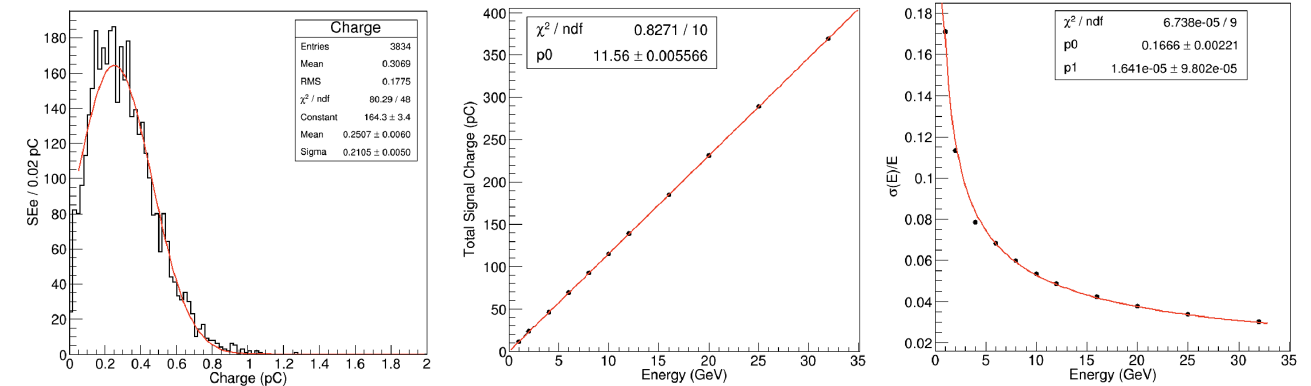
Figure 5. The simulated charge spectrum of a single layer ( left ), the MC predictions of the response linearity ( center ) and the energy resolution ( right ) of the 16-layer SE calorimeter